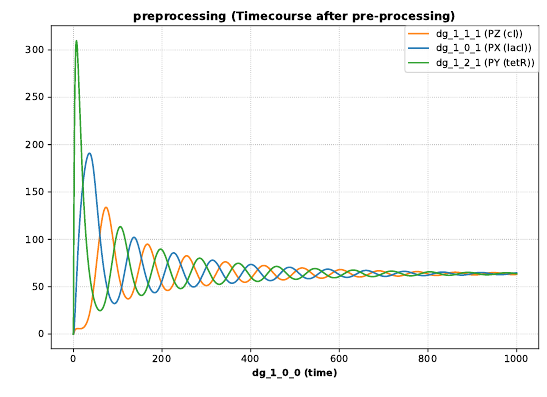
Figure 1.4: Time-course simulation of the repressilator after changing param- eters tps repr and tps active . Simula- tion with tellurium [5].